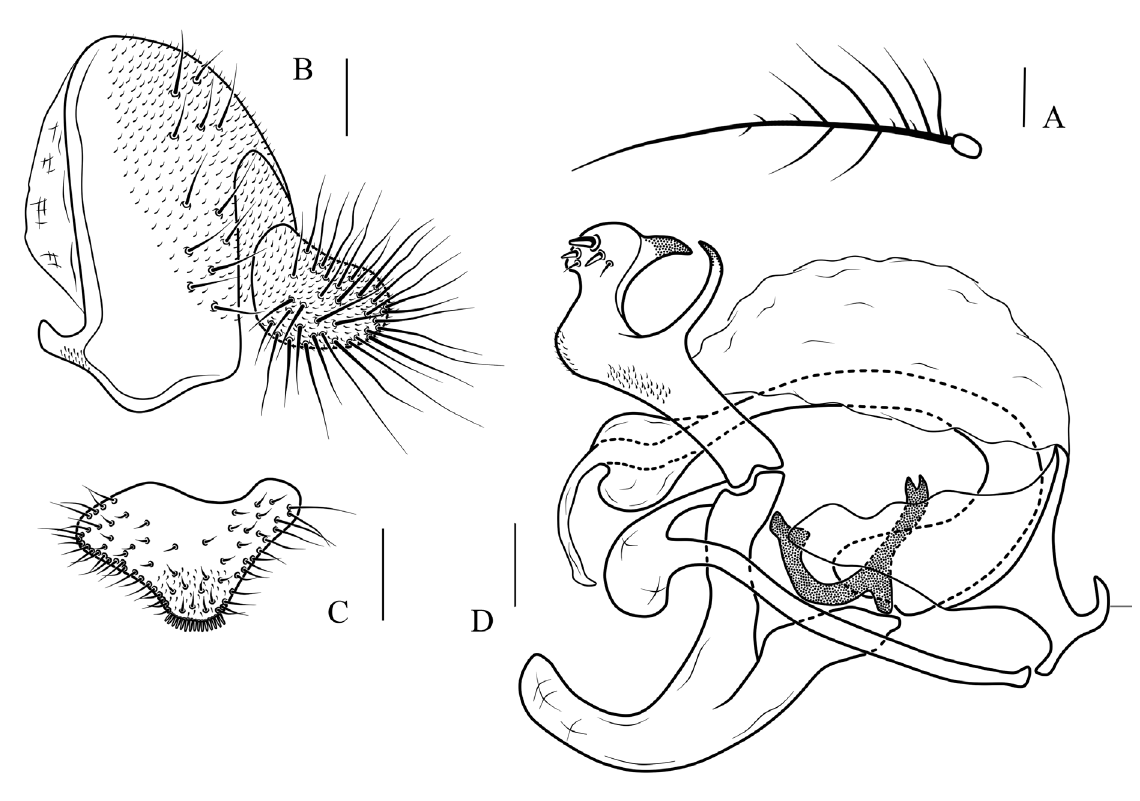
Fig. 3. Phortica ( Phortica ) kava sp. nov., ♂. A . Arista. B . Epandrium and cercus. C . Surstylus. D . Hypandrium, paramere, aedeagus and aedeagal apodeme. Scale bars = 0.1